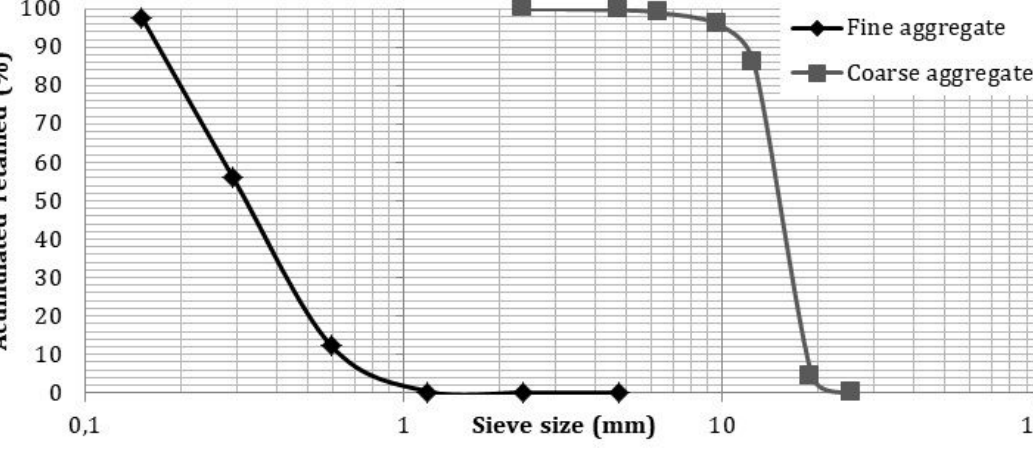
Figure 2. Particle size distribution of